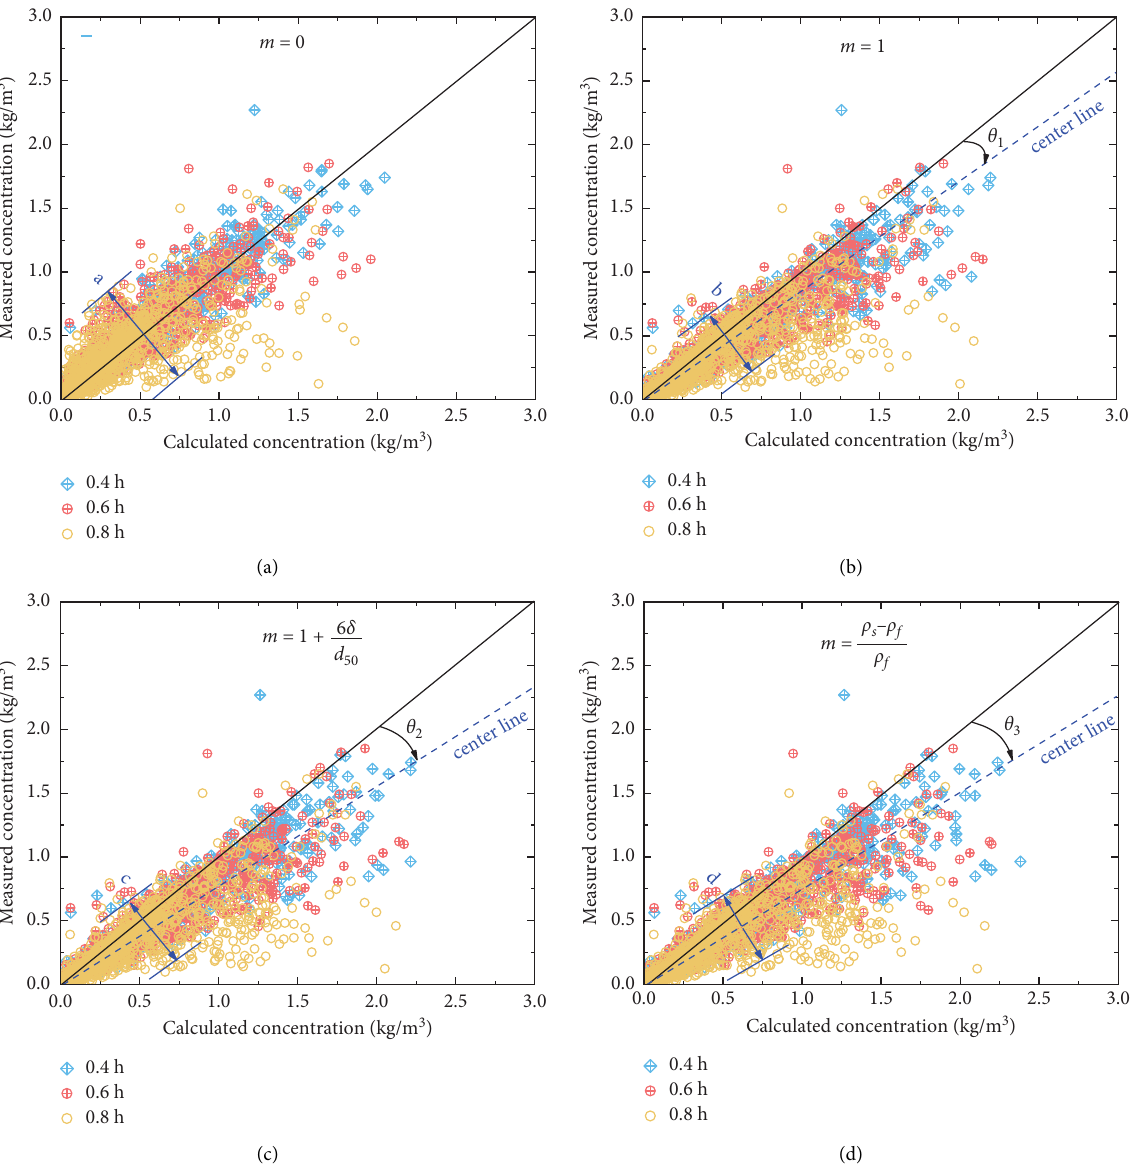
Figure 4: Verifcation of sediment concentration with diferent vertical time-averaged velocities. Among them, (a) the verifcation of sediment concentration with Rouse’s assuming zero value, (b) the verifcation of sediment concentration with Velikanov’s gravity theory hypothesis, (c) the verifcation of sediment concentration with Zhang’s viscous hypothesis, and (d) the verifcation of sediment con- centration with Cao’s turbulence hypothesis. In all fgures, the black solid line is a 45 ° diagonal line, and the blue-dotted line is the linear ftting center line of scattered points. Te smaller the angle between the two lines, the higher the calculation accuracy; the width of the strip area with scattered points indicates the concentration of calculation accuracy. Te smaller the width, the better the